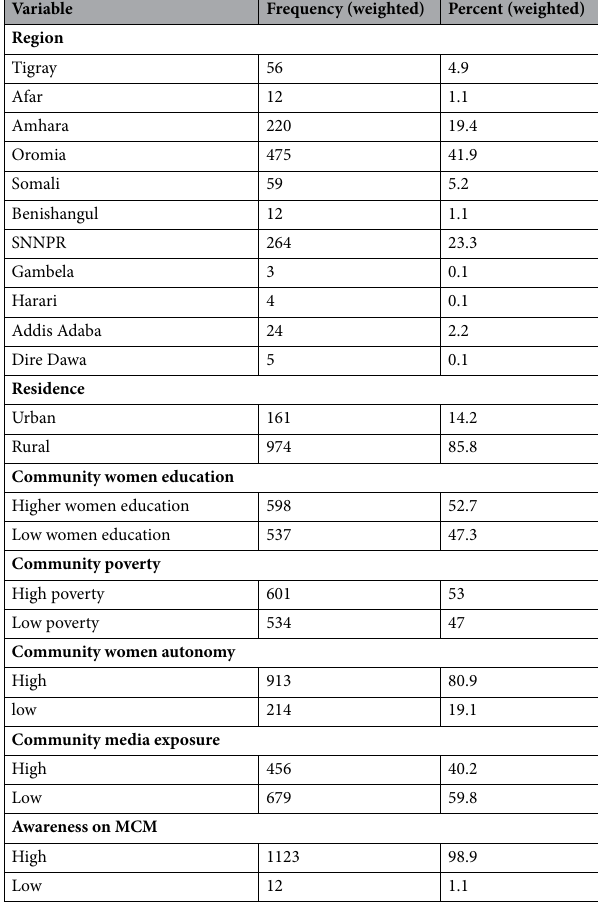
Table 2. Community-level characteristics of pregnant women in EDHS 2016.